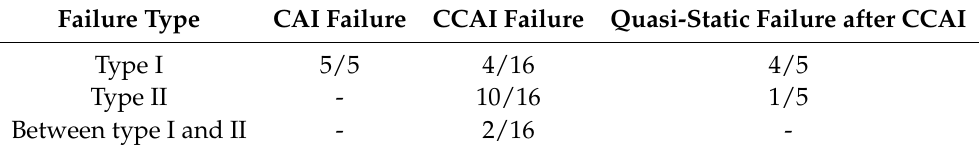
Table 3. Frequency of occurrence of the observed failure modes for specimen broken under quasi- static load (CAI), cyclic load (CCAI), and quasi-static load after cyclic loading (In total, 26 specimens were tested until failure. The missing 27th specimen in Table 2 was used for cross section images before the final failure (cf. Figure